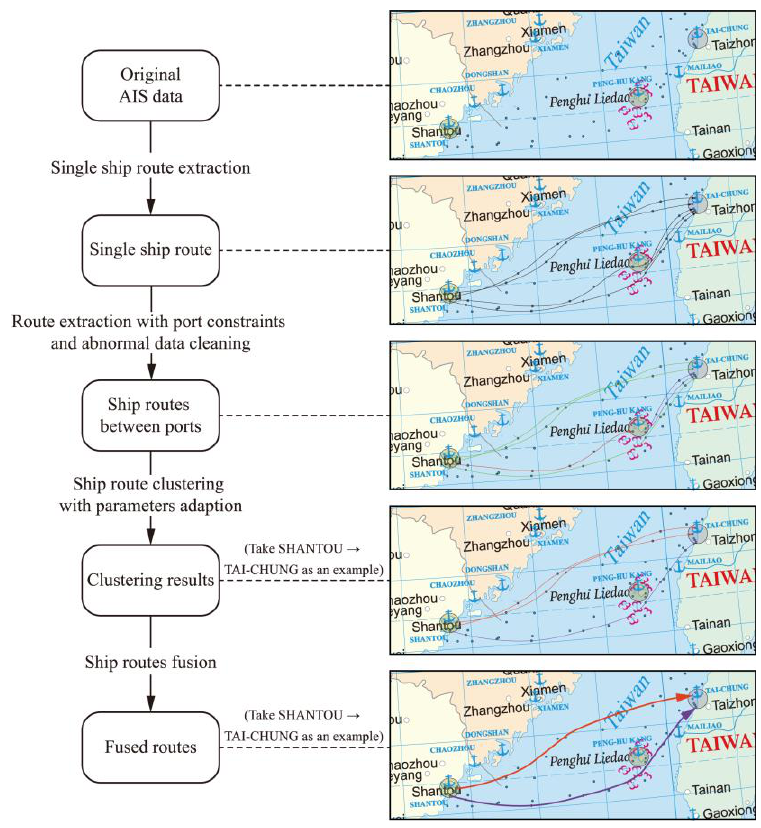
Figure 2. Flowchart of BIRCH clustering based on resampling.